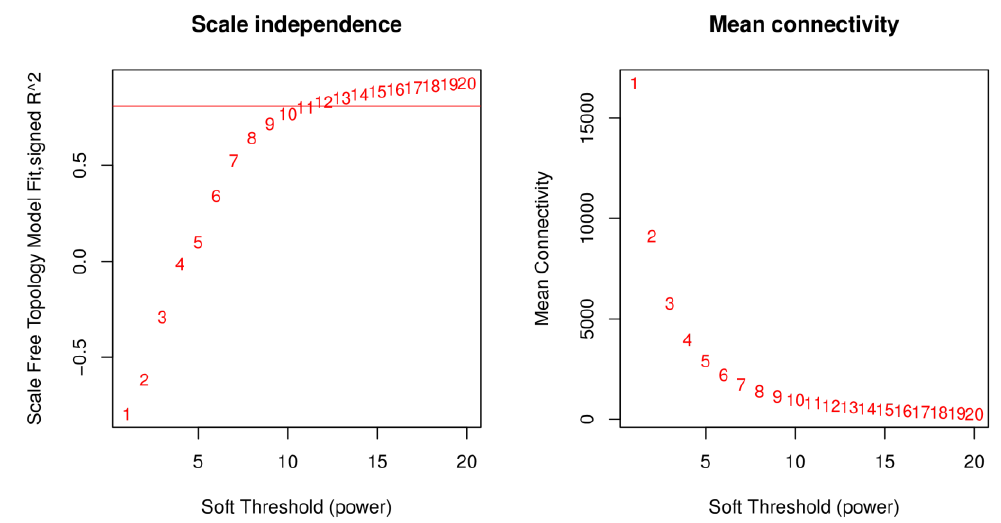
Figure 2. Determination of soft threshold. Network topology for different soft-thresholding powers of WAT-2020-17-6. The x-axis represents the soft threshold β . The y-axis of the left figure represents the square of the correlation coefficient between log(k) and log(p(k)) in the corresponding network. The y-axis of the right figure represents the mean of all gene adjacency functions in the corresponding gene module. The approximate scale-free topology can be attained at the soft thresholding power of 11.